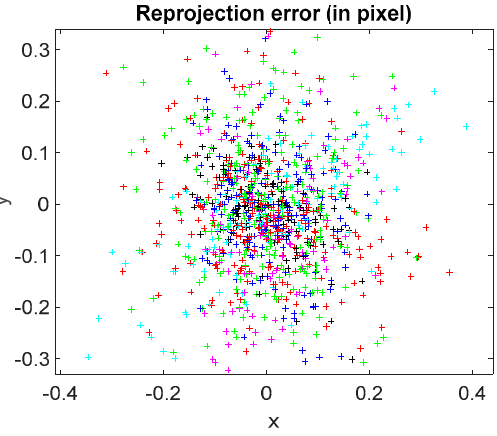
Figure 6. Reprojection error of the calibrated camera.